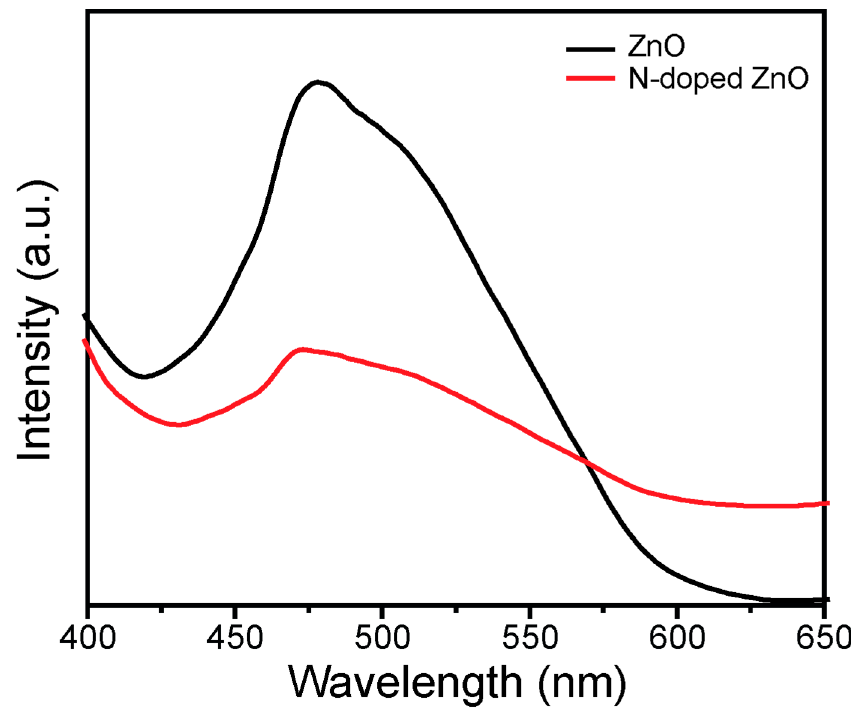
Figure 6. Photoluminescence spectra of ZnO and N-doped ZnO.